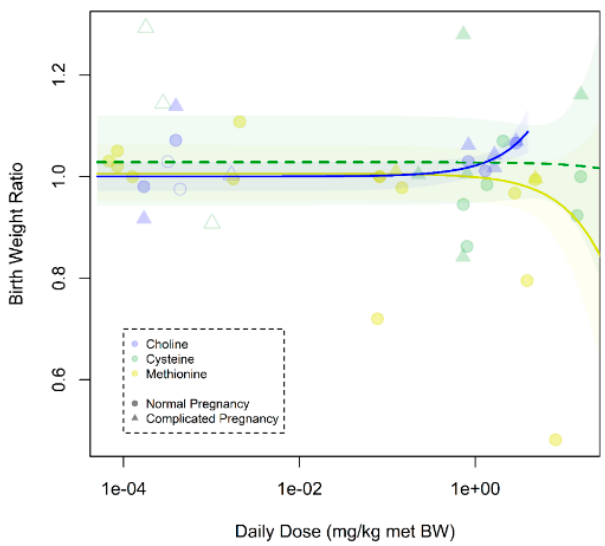
Figure A12. Dose-response curve on prenatal supplementation of methyl donors on fetal/birth weight in all pregnancies. There was a dose-response relationship between birth weight ratio and daily dose of methyl donors ( p slope = 0.0002). Excessive doses of methionine and cysteine resulted in lower birth weight (methionine p slope = 1.09 * 10–5; cysteine p slope = 0.16). Daily dose is expressed as mg per kg metabolic body weight. Open dots indicate human studies and closed dots animal studies.